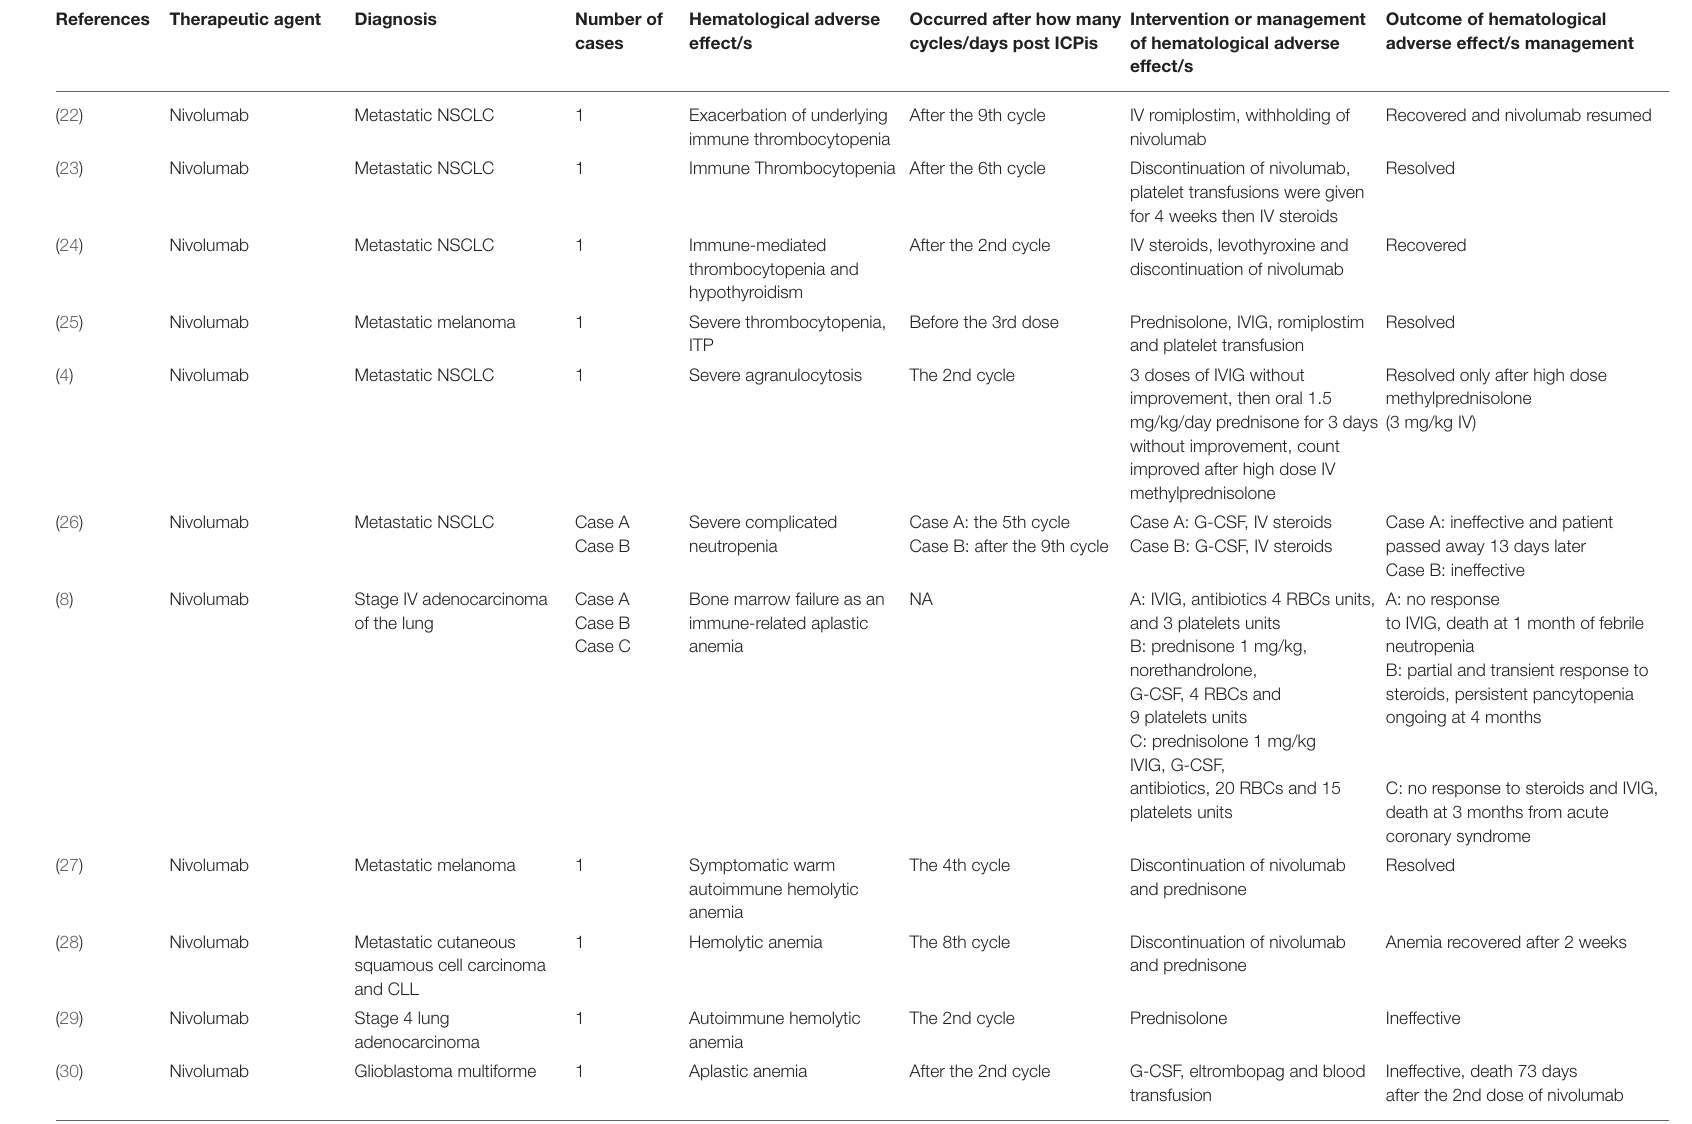
B: prednisone 1 mg/kg, norethandrolone, G-CSF, 4 RBCs and 9 platelets